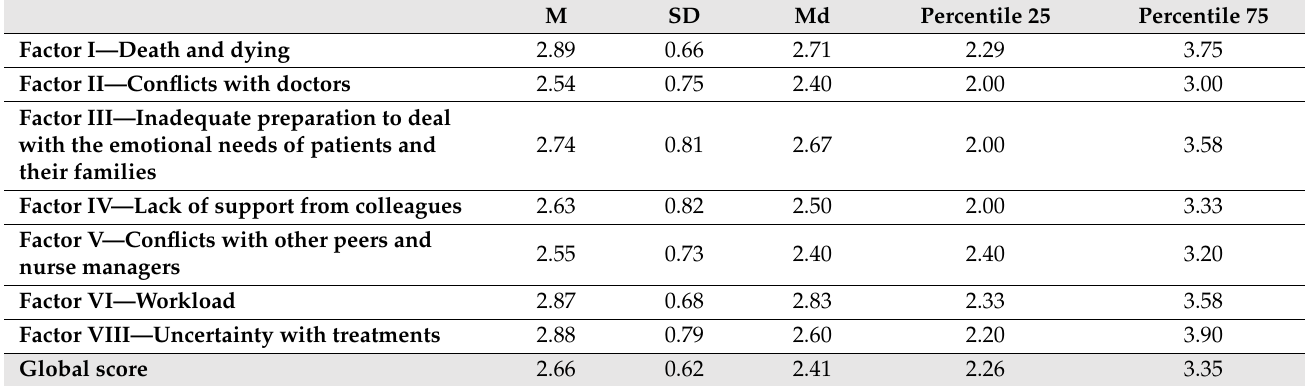
Table 1. Descriptive statistics of Nurse Workplace Stress